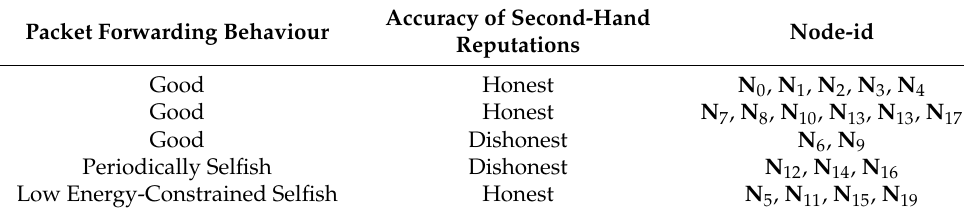
Table 6. Behaviours displayed by the various nodes. Accuracy of Packet Forwarding Behaviour